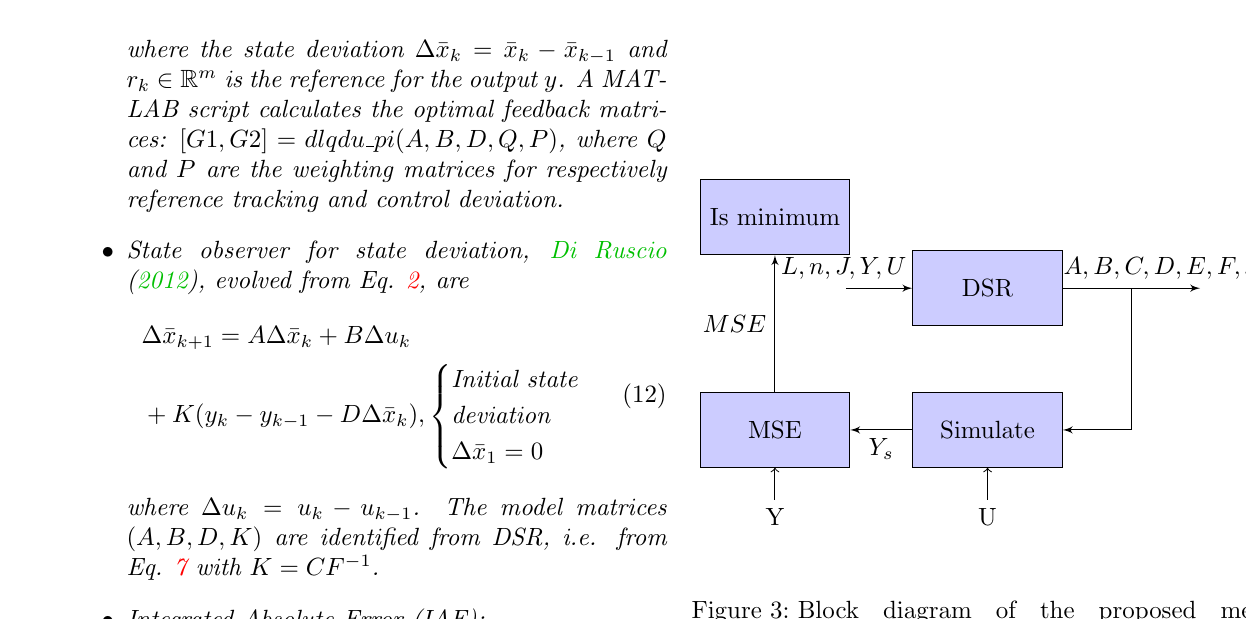
Figure 3: Block diagram of the proposed mem- bers working together through iterations of L, n, J , each bounded as described in Eq. 8. The optimal model, meaning the model giv- ing the lowest MSE, is choosen. The ‘DSR’ block is as Eq. 7 and the ‘MSE’ block is as Eq. 9.